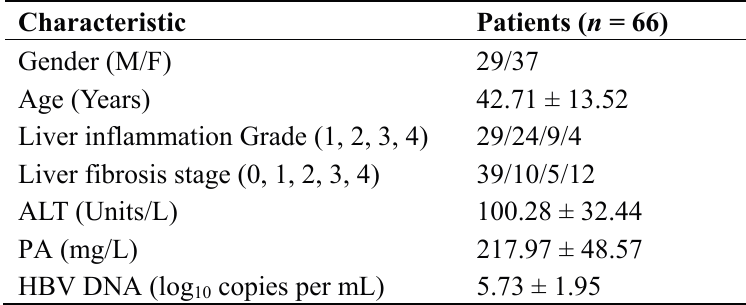
Table 1. Complications and laboratory tests in patients with hepatitis B virus (HBV) (mean ± SD, n = 66).